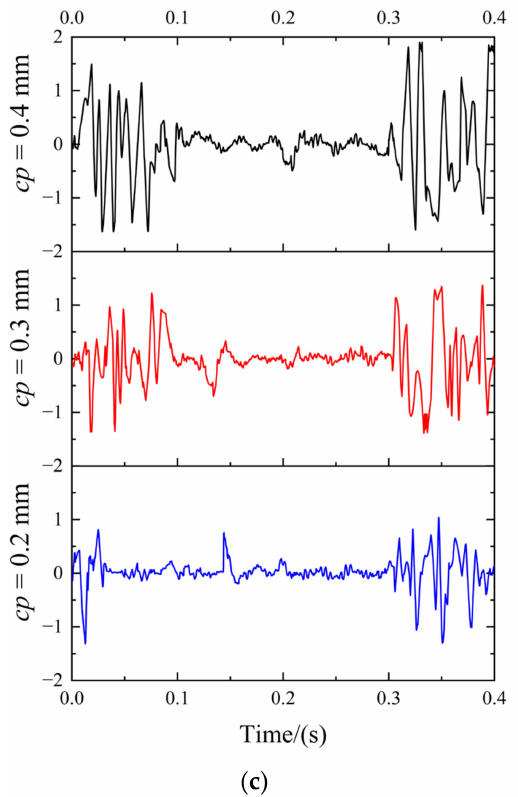
Figure 16. Variation of roller skew angle under different working conditions. ( a ) T = 539 N · m. ( b ) T = 809 N · m. ( c ) T = 1078 N · m.